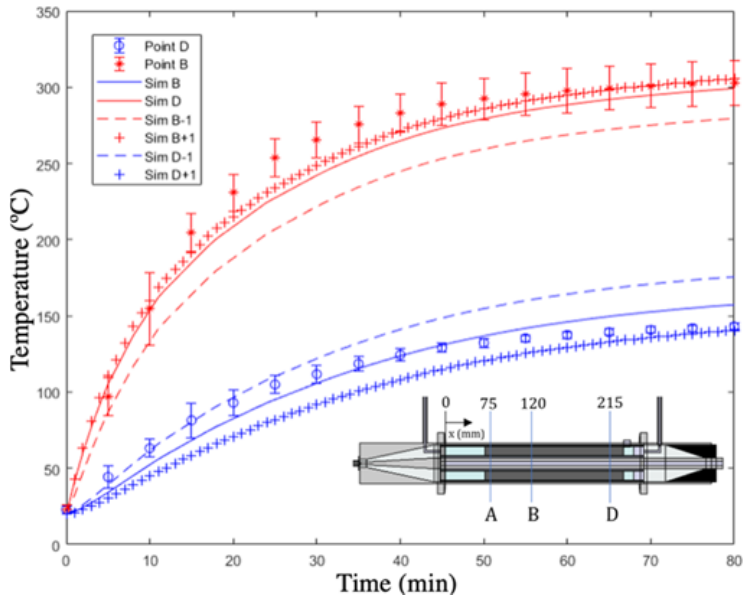
Figure 6. Comparison of the experimental and simulated transient temperatures in the β‐ SiC loaded packed ‐ bed under 60W microwave power input (B and D are the locations of the thermo ‐ couples).